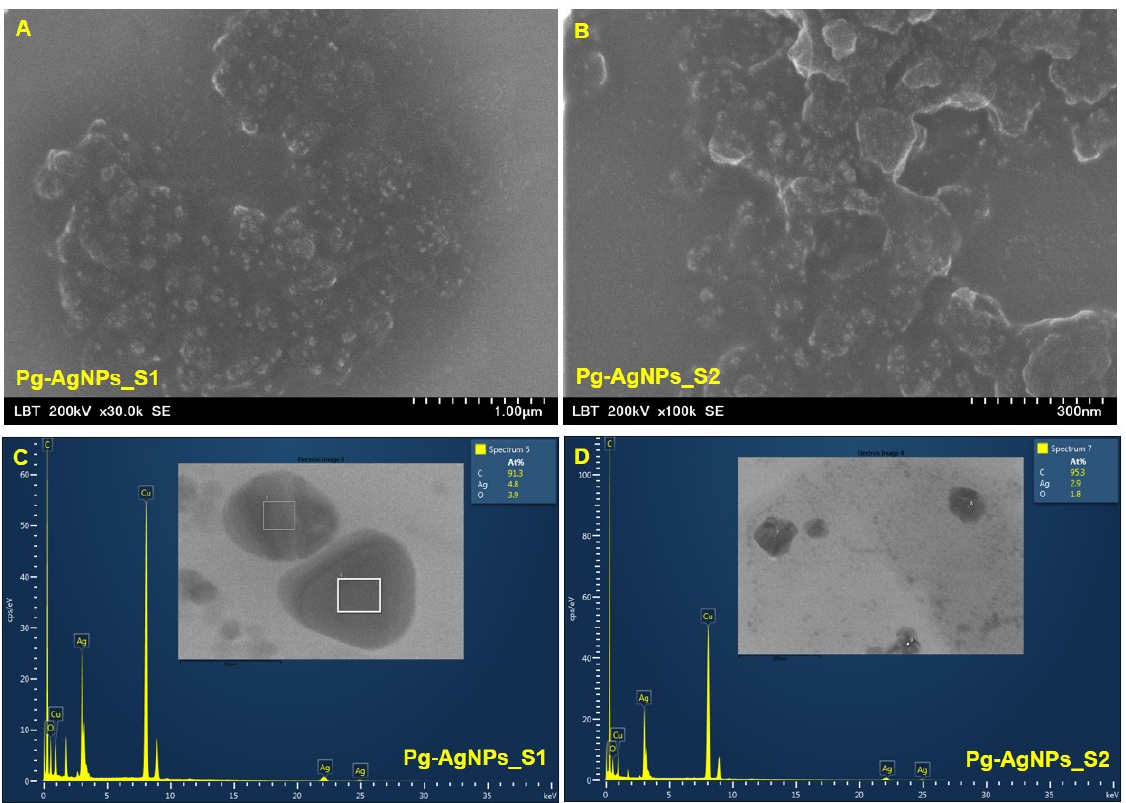
Figure 3. SEM-EDX images of Pg-AgNPs obtained by green synthesis, at 25 °C (Pg-AgNPs_S1— A and C ) and at 60 °C (Pg-AgNPs_S2— B and D ). and C ) and at 60 ◦ C (Pg-AgNPs_S2— B and D